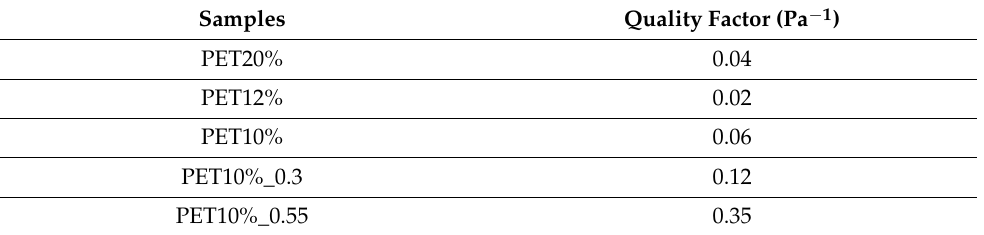
Table 5. Quality factor of different